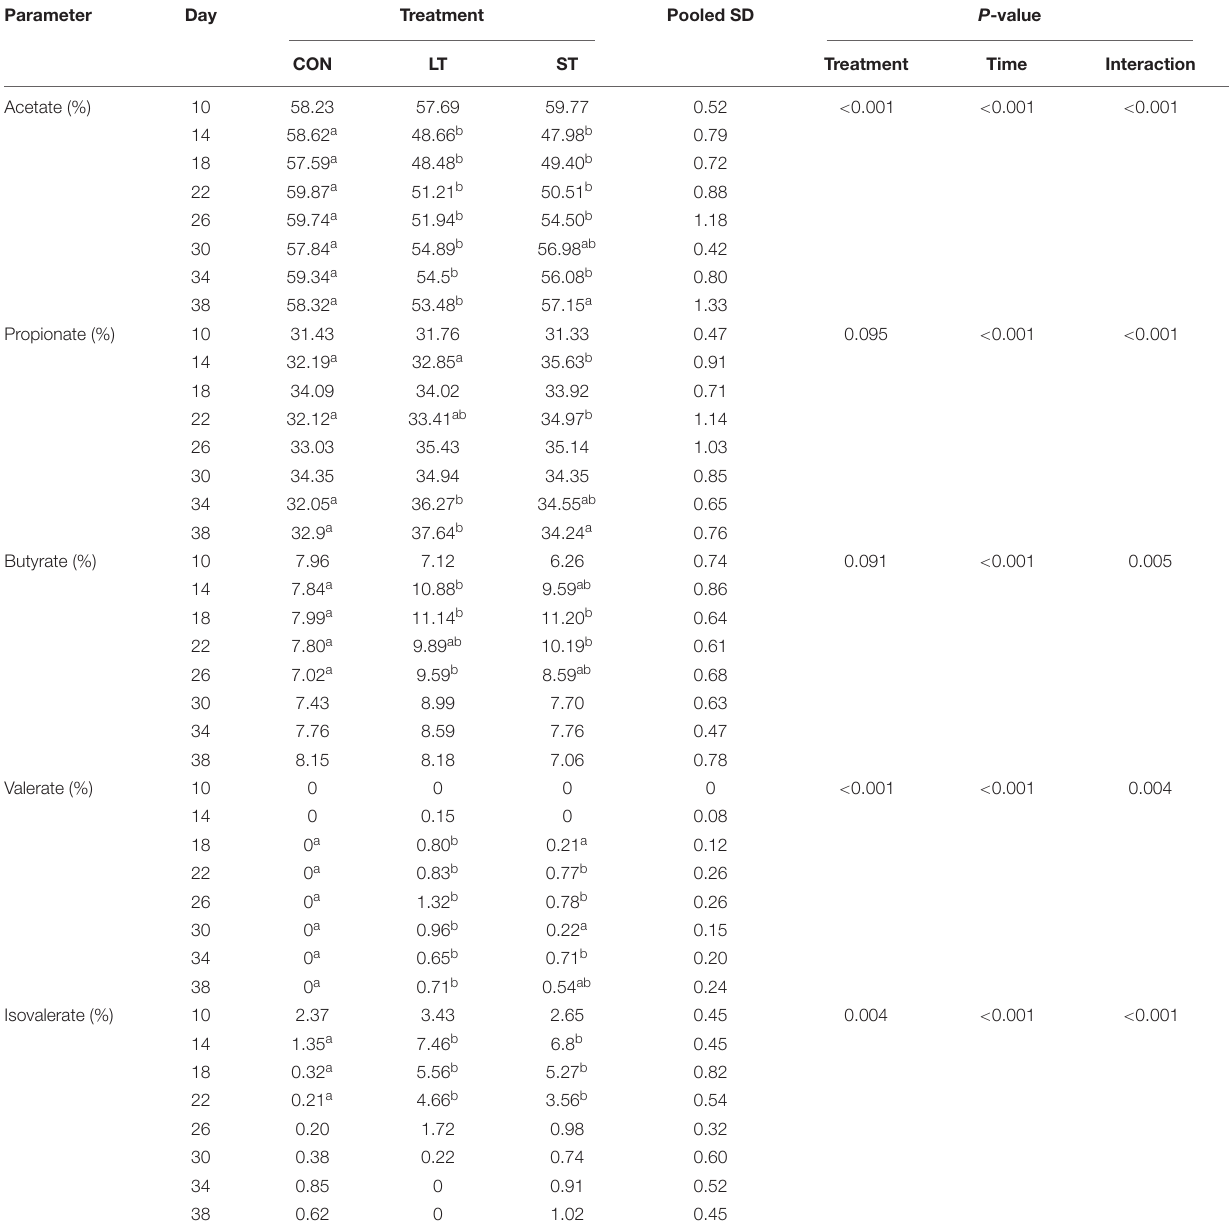
TABLE 2 | Molar proportions of acetate, propionate, butyrate, valerate, isovalerate at day 10 (baseline period), and every fourth day of experimental period (days 14–38). Parameter Day Treatment Pooled SD P -value Treatment Time